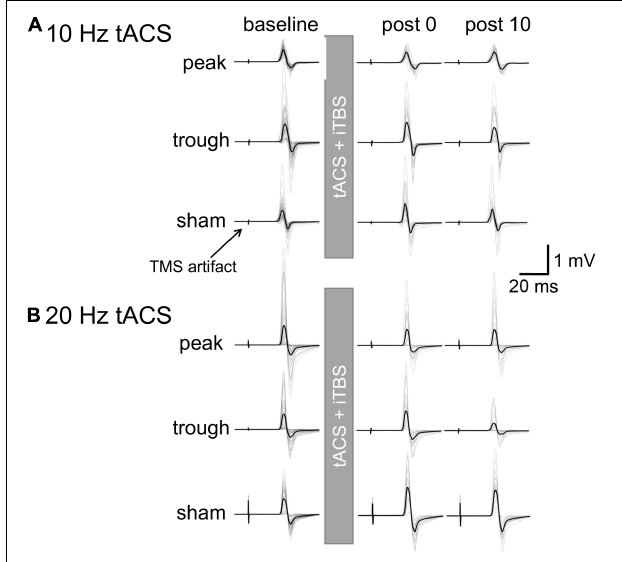
FIGURE 2 | Motor evoked potential waveforms from a representative participant for iTBS with α - or β -tACS. MEP waveforms are shown for the baseline and 0 and 10 min after the combined stimulation. Thick lines indicate the mean waveform calculated from 24 trials in each session. Thin lines indicate each of the 24 trials. (A) iTBS with α -tACS. MEPs increased after the trough and sham conditions but were suppressed after the peak condition. (B) iTBS with β -tACS. Compared with the sham condition, MEPs were inhibited after both the peak and trough conditions, which differed from the iTBS/ α -tACS results. For actual data analysis, MEP amplitudes were measured for each trial, not for average